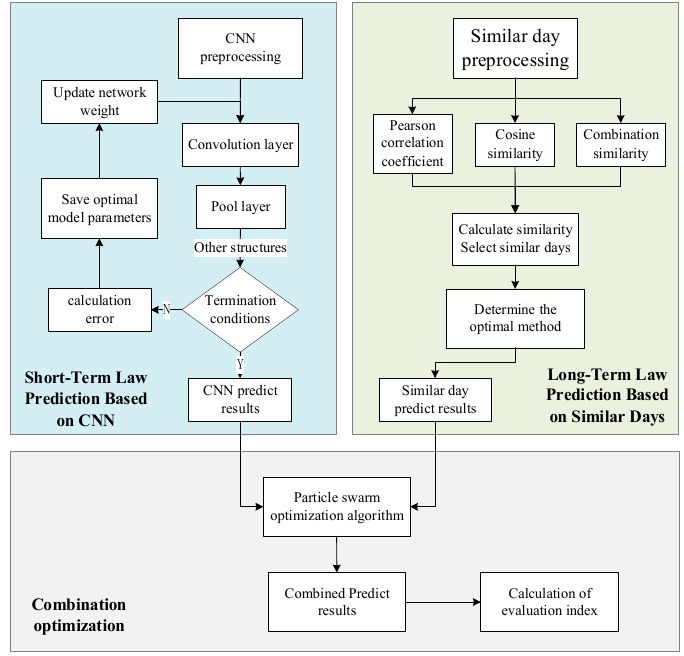
Figure 3. Model structure diagram.